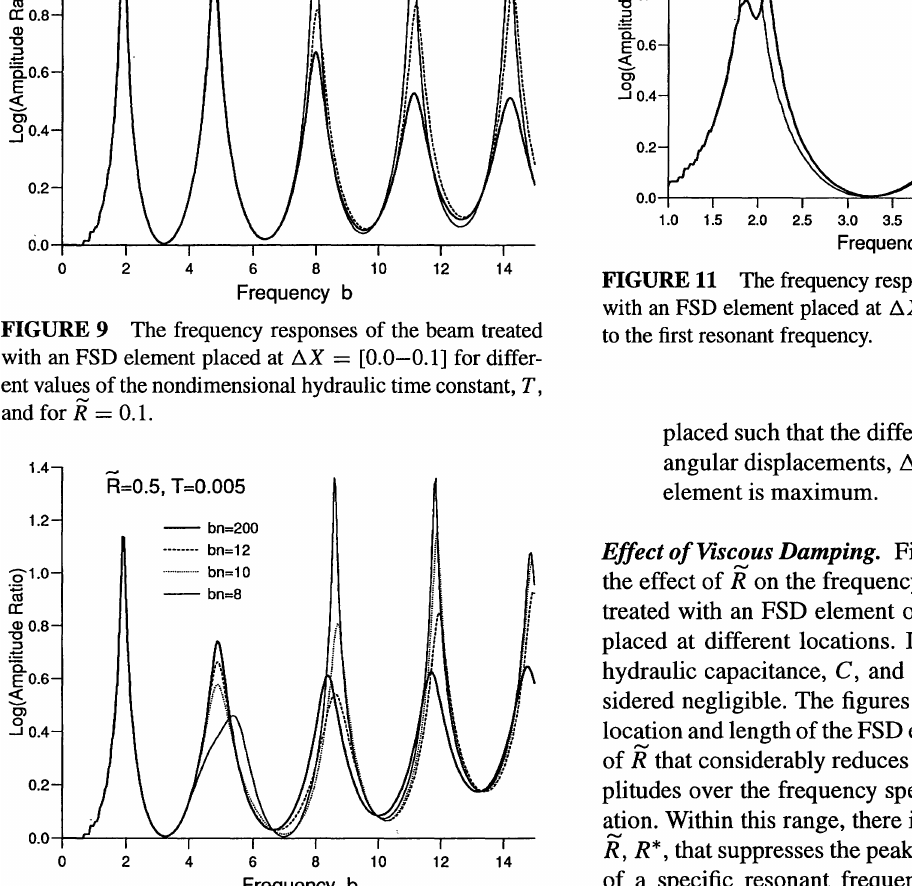
FIGURE 10 The frequency responses of the beam treated with an FSD element placed at AX = [0.0-0.1] for dif ferent values of the nondimensional frequency, bn, and for T = 0.005 and Ii = 0.5.